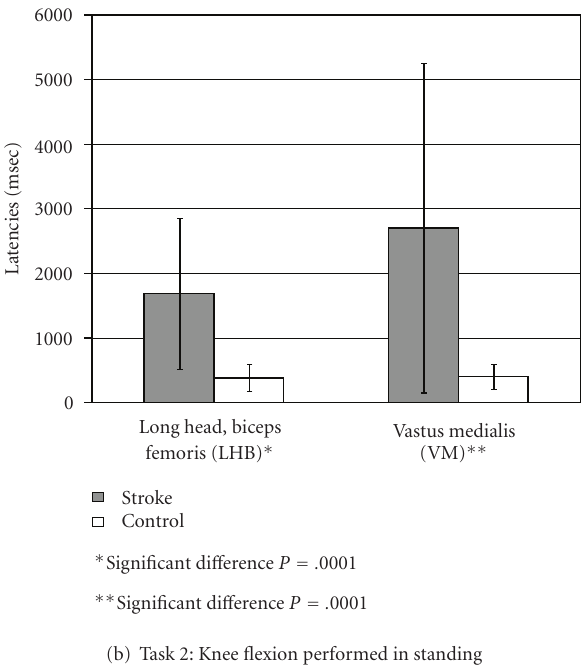
Figure 3: Comparison of deactivation latencies for control and stroke subjects.